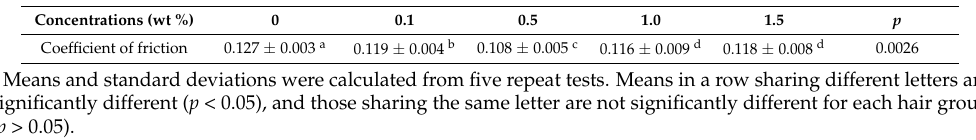
Figure 3. Typical friction coefficients curves of the base oil with different concentrations of MoO 3 additives. Table 3. Average friction coefficients of the base oil with different concentrations of MoO 3